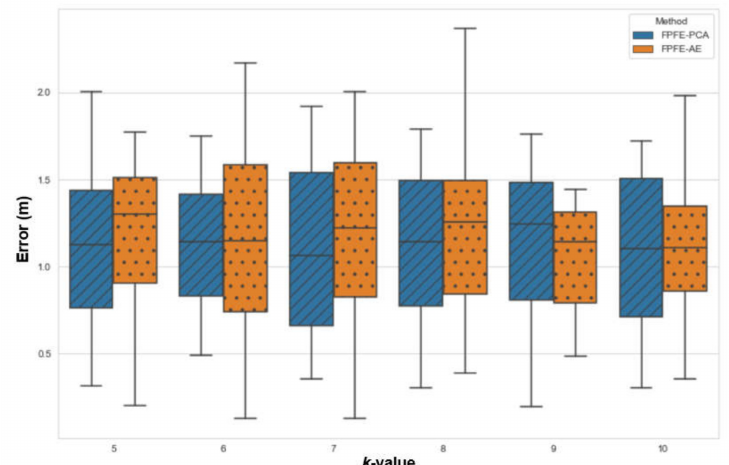
Figure 9. The localization error box-whisker plots of FPFE with 54 random RPs for k RP candidates, where k = 5, 6, 7, 8, 9, and